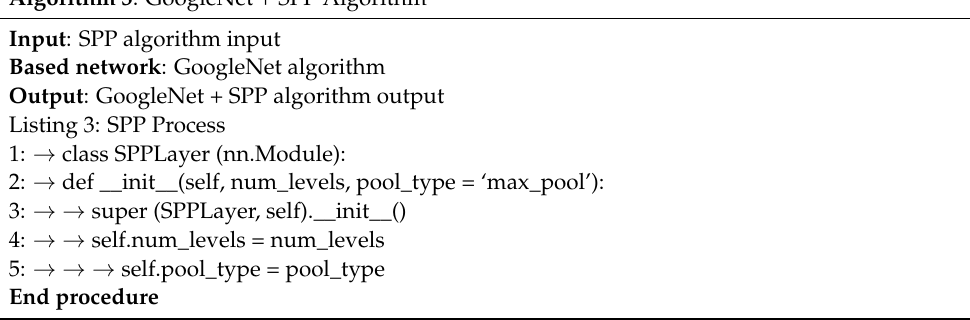
Algorithm 3 : GoogleNet + SPP Algorithm